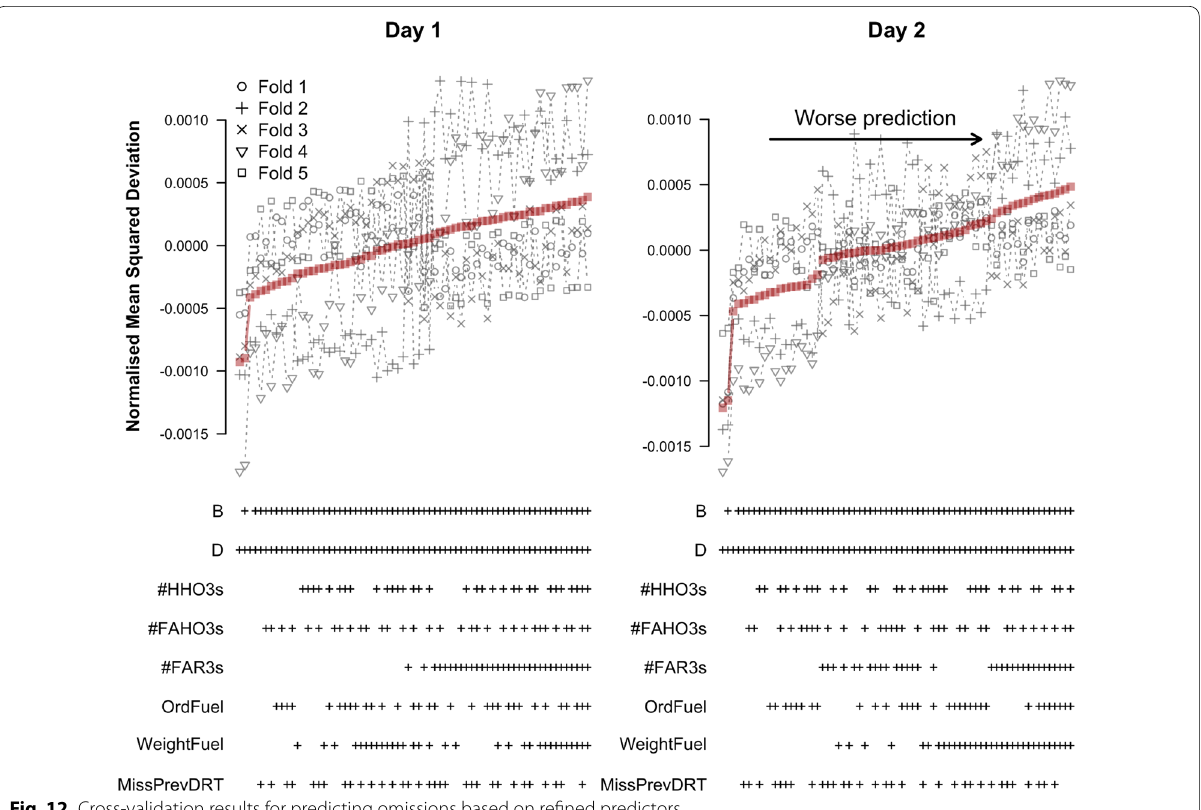
Fig. 12 Cross-validation results for predicting omissions based on refined